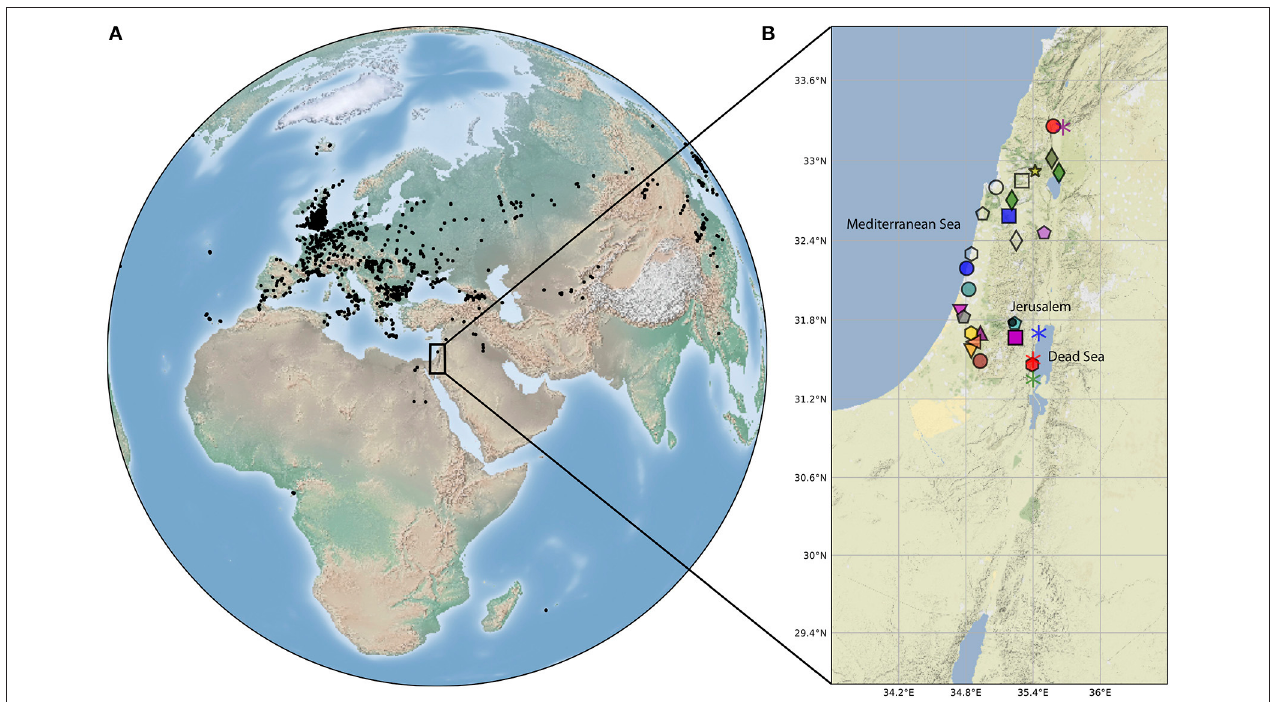
FIGURE 1 | (A,B) Location map. Dots on the world map show locations of all the paleomagnetic data from archaeological and volcanic sources from the past four millennia available in the GEOMAGIA50 database (Korhonen et al., 2008; Brown et al., 2015). The enlarged map shows locations of archaeomagnetic sites that passed the acceptance criteria in Table 2 and listed in Table 3 . Symbols and colors are as in Figure 3 , where closed symbols show data from this study and open symbols show data from Segal (2003). Locations of sedimentary cores data shown in Figure 4 are shown with asterisks with the same color code as in Figure 4